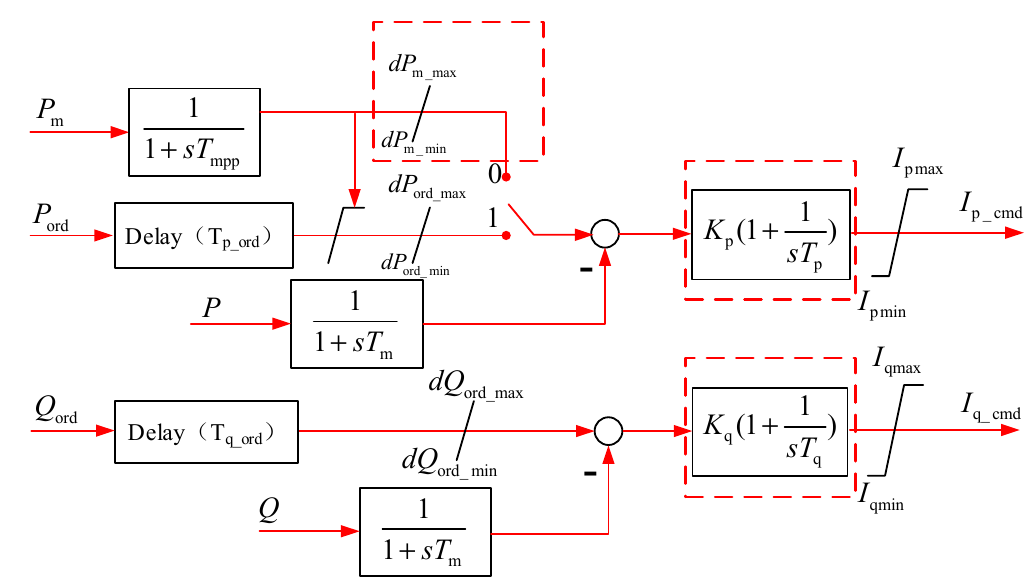
Figure 1. Control structure diagram of the photovoltaic (PV) unit.